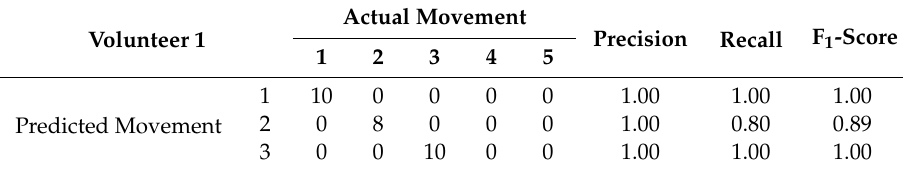
Table A1. Results Volunteer 1.